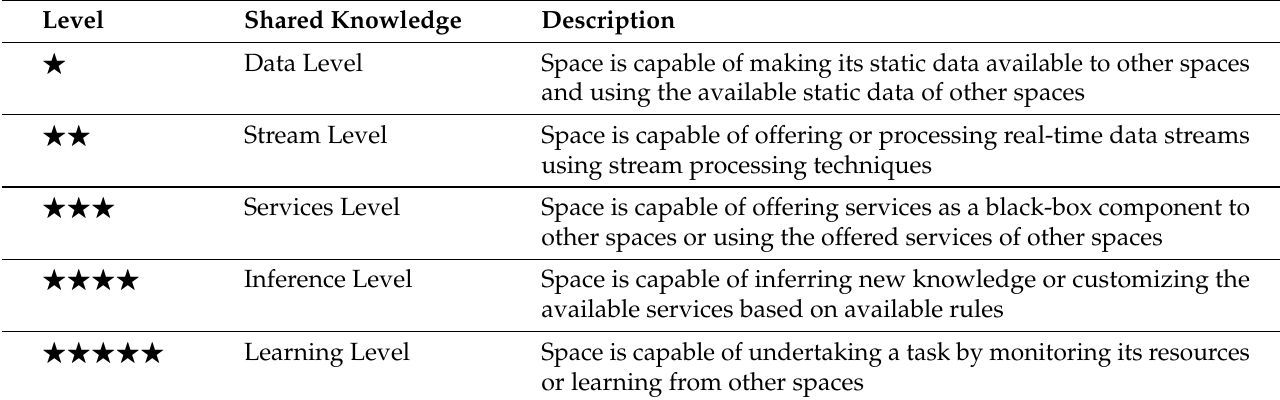
Table 1. The five-star maturity level of knowledge sharing and reuse in smart environments. Level Shared